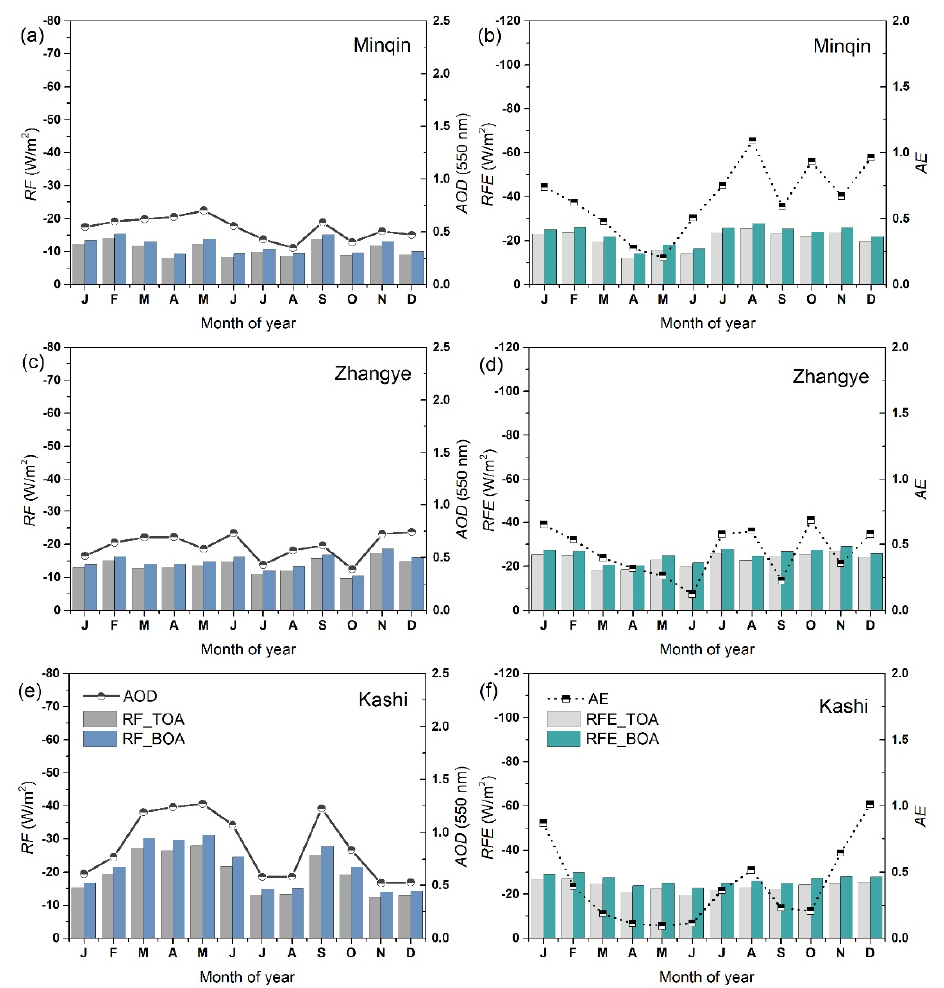
Figure 2. Multi-year monthly average aerosol radiative forcing (RF) and e ffi ciencies (RFE) and corresponding aerosol optical depth (AOD) at 550 nm and Ångström exponent (AE) (440–870 nm) at the SONET arid and semi-arid sites. ( a , b ) Minqin; ( c , d ) Zhangye; ( e , f ) Kashi.